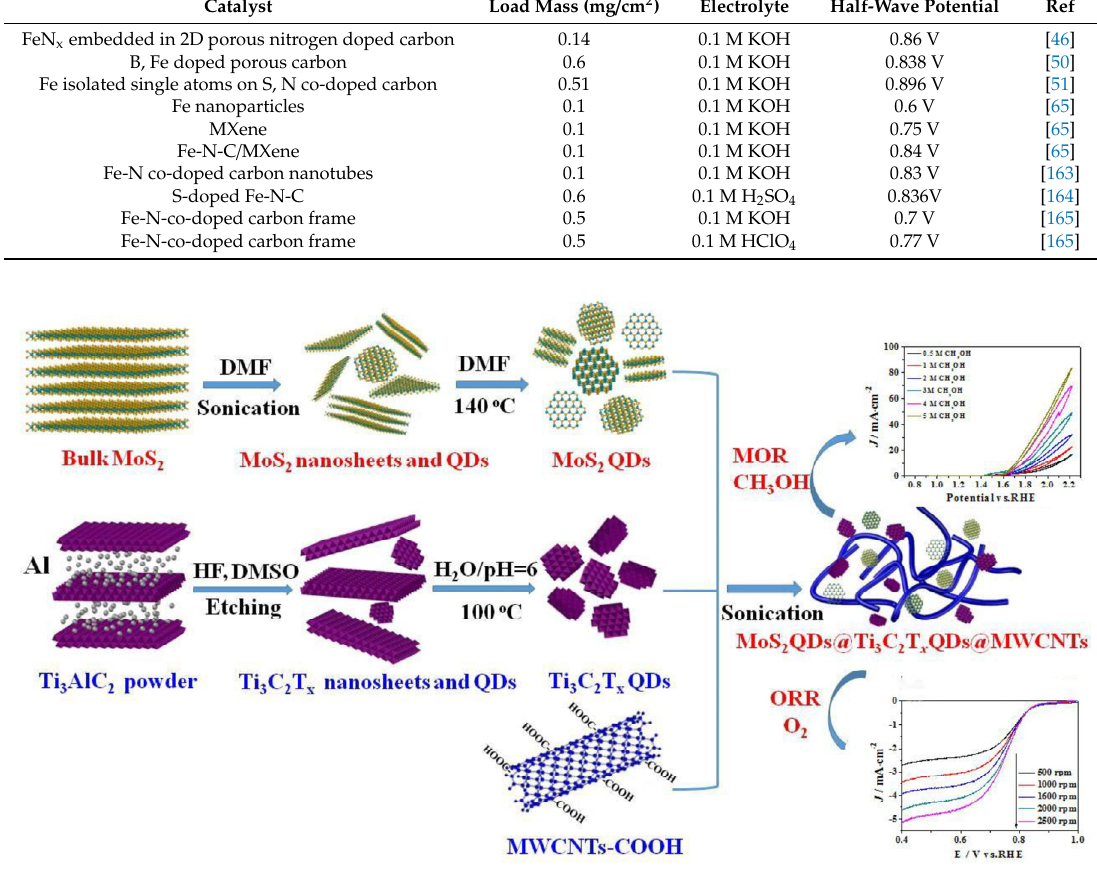
Figure 10. MoS 2 QDs@Ti 3 C 2 T x QDs@MMWCNTs for the methanol oxidation and oxygen reduction reactions in basic solution. Reprinted with permission from [51].